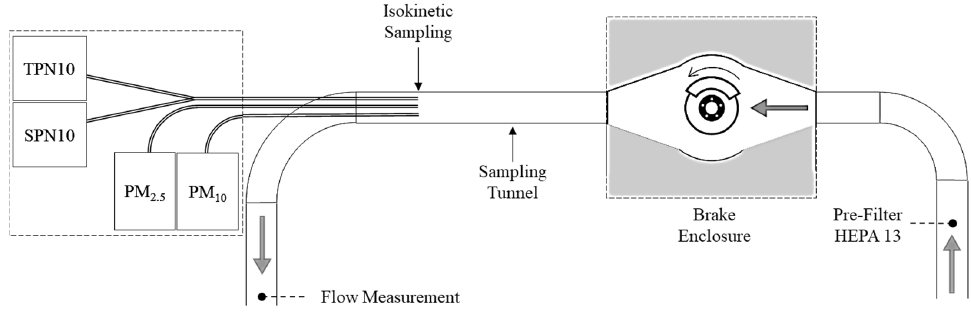
Figure 1. Overview of the layout based on which the testing facilities carried out brake emissions testing during the ILS. The illustration of certain elements (e.g., flow measurement device, calliper orientation, positioning of HEPA filter, and use of flow-splitting for PN measurement) is indicative.